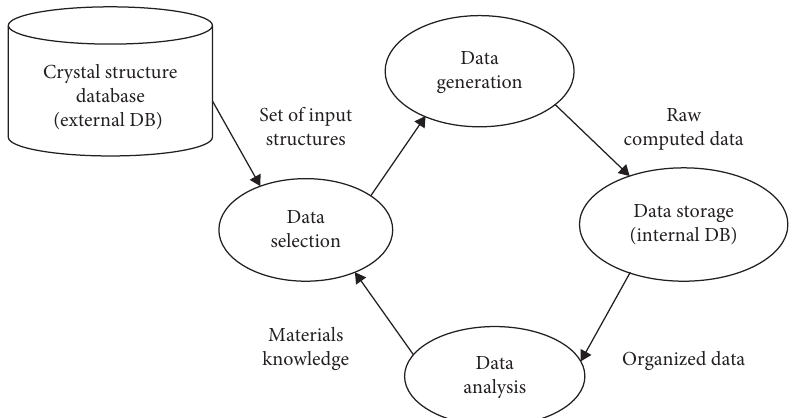
Figure 3: Data flow chart of screening materials by high-throughput calculation [59,